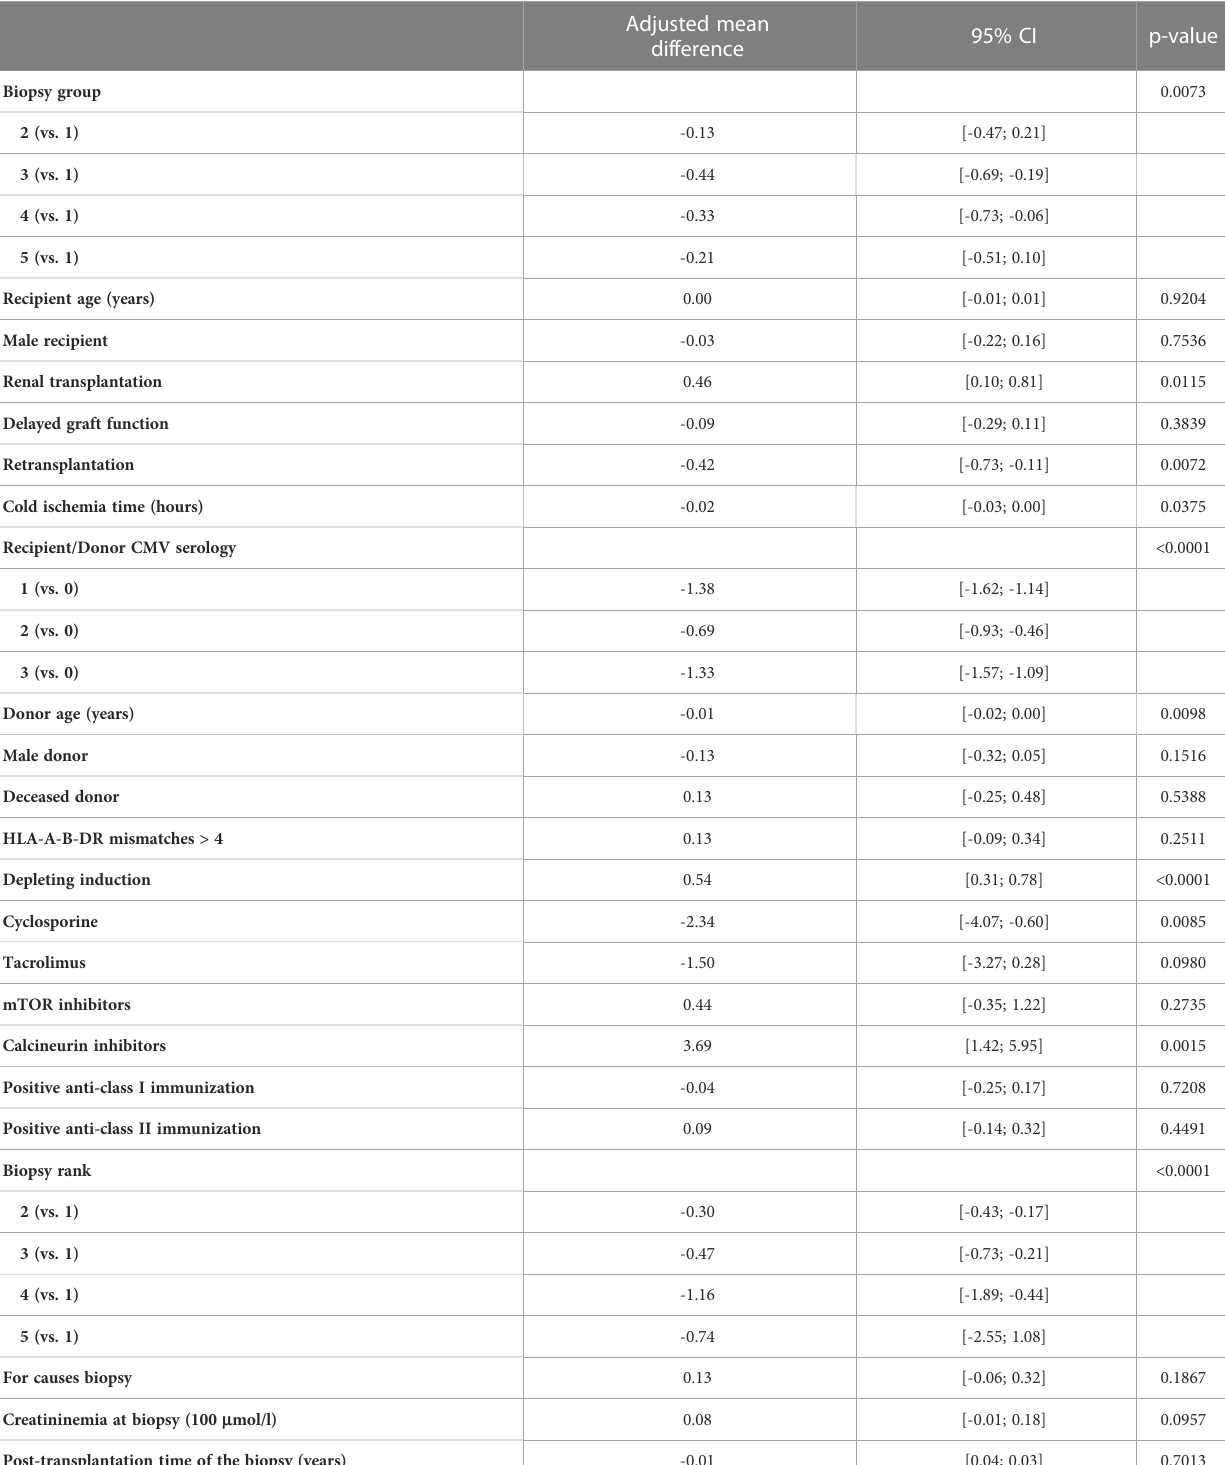
TABLE 4 Results of the multivariable linear mixed model of log of the ratio between B lymphocytes in absolute number and CD28-CD8+ T cells in absolute number measured at the time of biopsy (5 biopsy